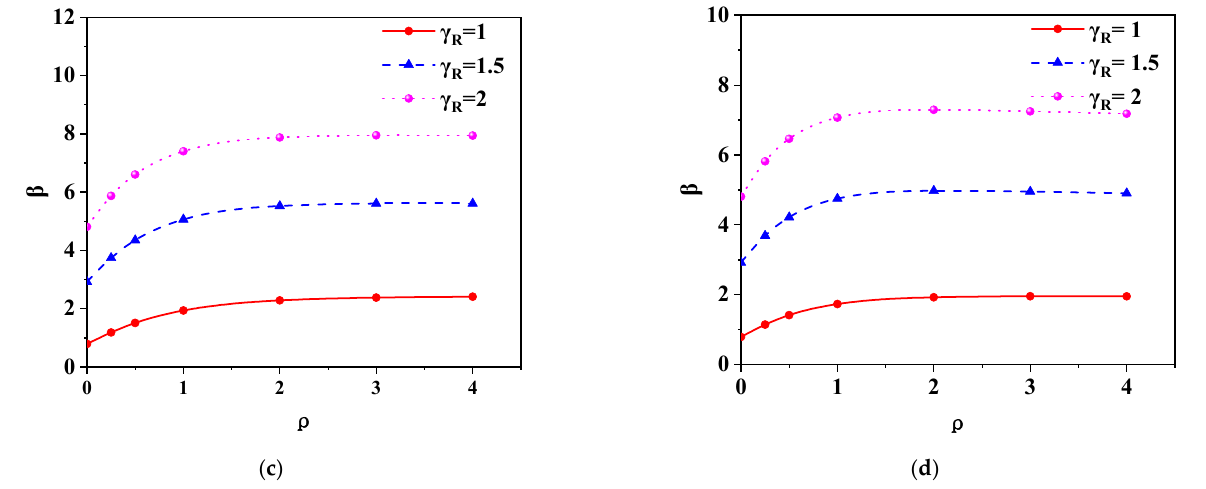
Figure 8. The relationship between β and ρ under different load types and partial factors for resistance (grade Ⅱ ): ( a ) D + R; ( b ) D + O; ( c ) D + W; ( d ) D + S.